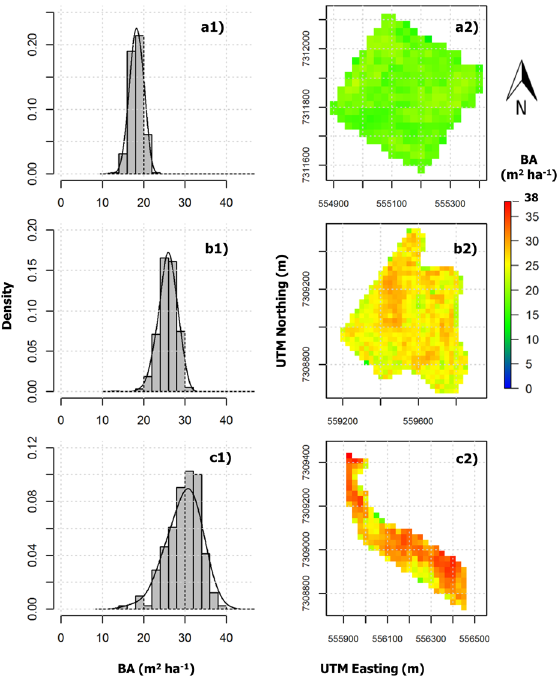
Figure 5 - Predicted BA (natural scale) at landscape